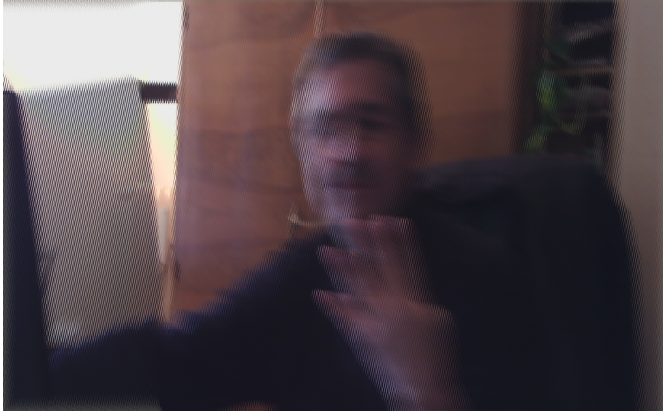
Figure 3. Native light-field image output of the Quilt in Figure 2 based on the per-device HoloPlay calibration .json values.